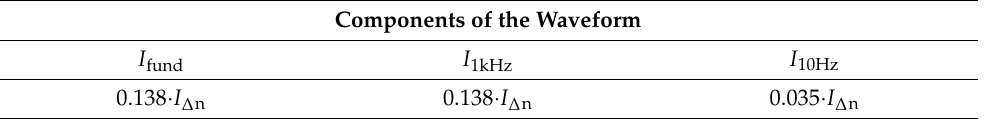
Table 1. Components of the mixed-frequency testing waveform used for F-type and B-type RCDs. Components of the Waveform